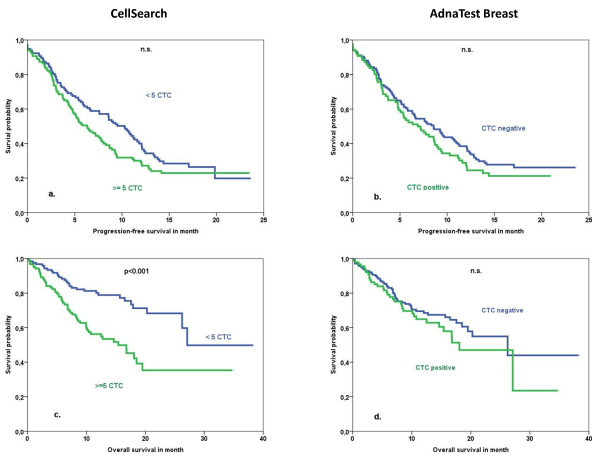
Patient outcome with the two different tests for CTC detestion. Progression-free survival for (a) CellSearch™ and (b) AdnaTest BreastCancer™. Overall survival for (c) CellSearch™ and (d) AdnaTest BreastCancer™. CTC, circulating tumor cell; n.s., not significant.